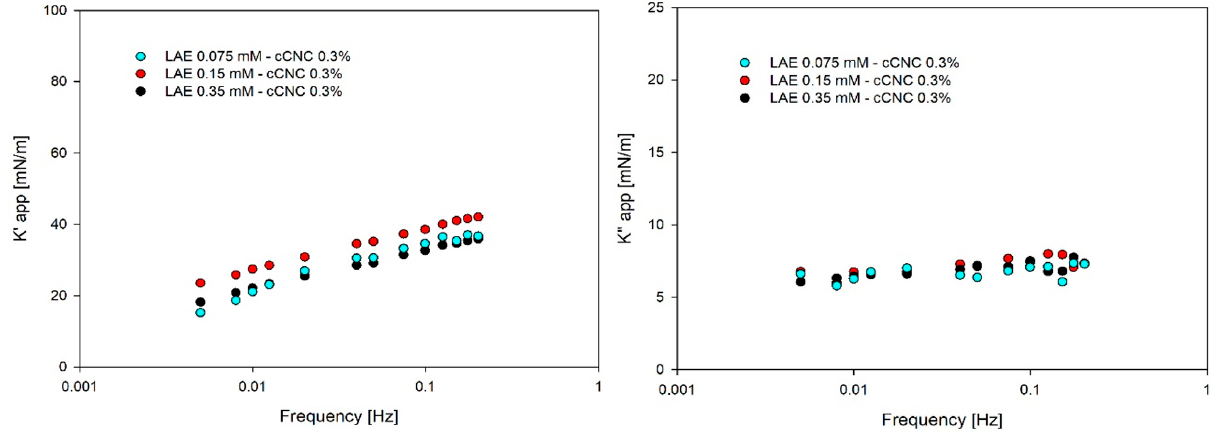
Figure 7. Apparent elastic (K’) and loss (K”) moduli for cCNC suspensions with various concentra ‐ tions of LAE (0.075 mM, 0.15 mM and 0.35 mM).